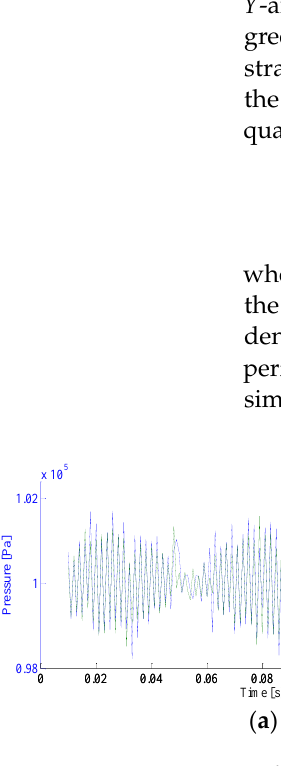
Figure 7. Comparison curves of ( a ) fluid pressure and circumferential strain at Point1; ( b ) fluid pressure and circumferential stress at Point1.